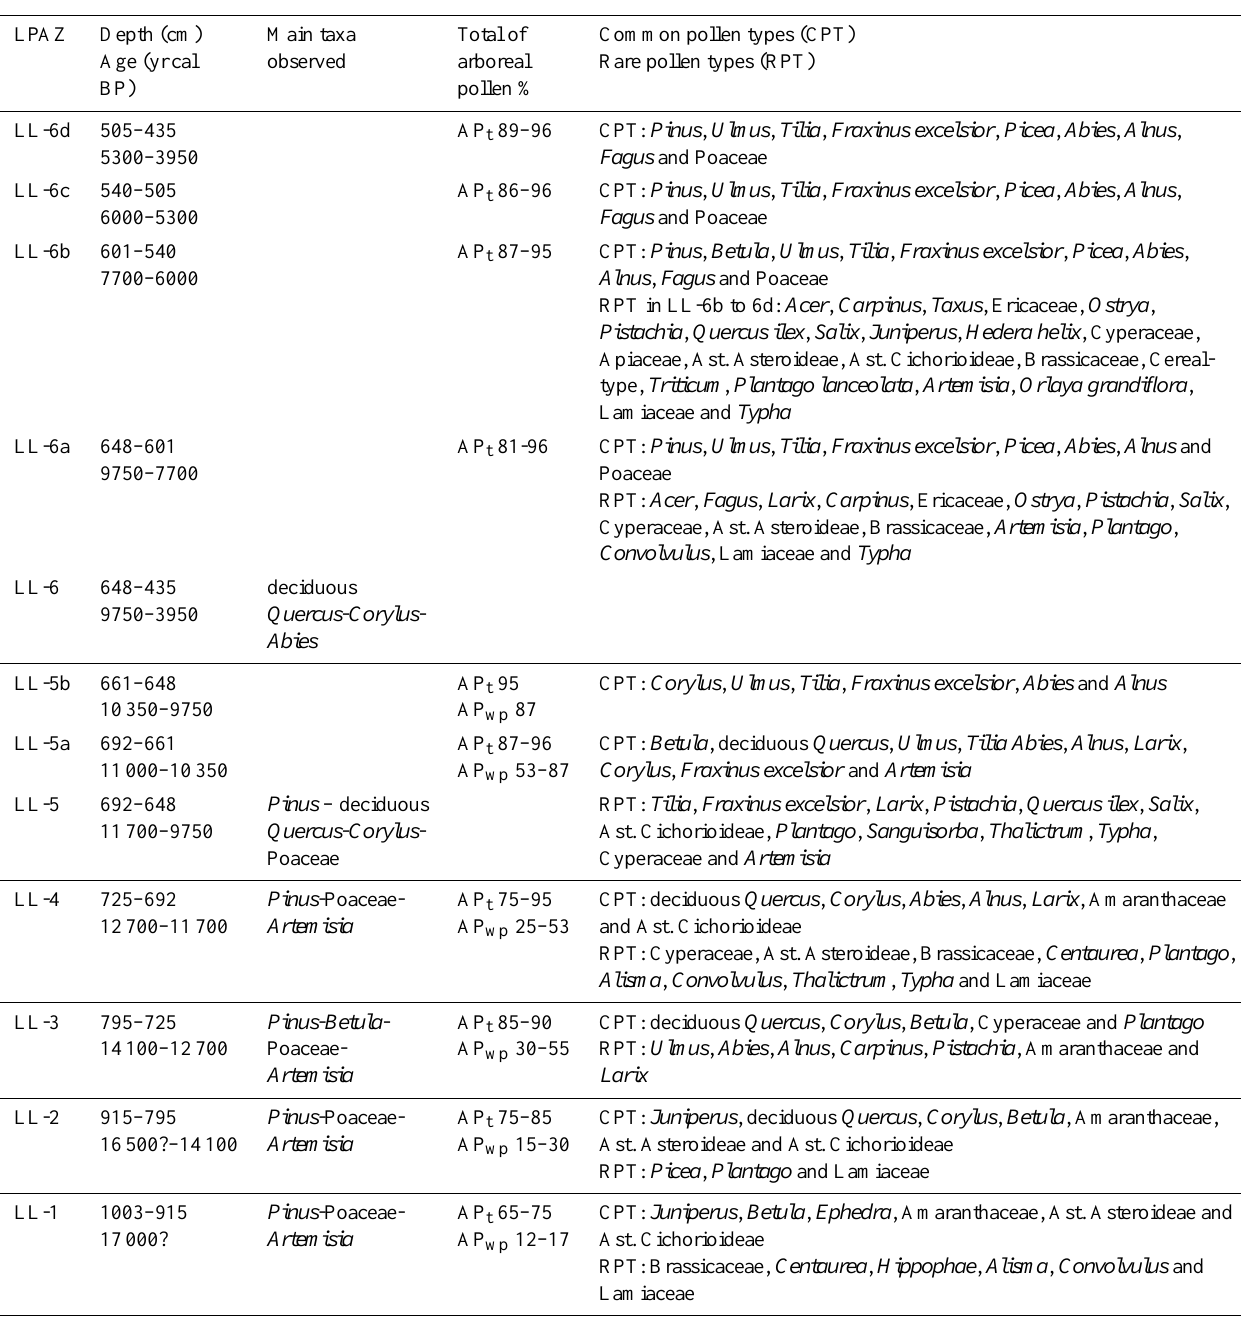
Table 2. Inventory of local pollen zones with depth and estimated ages, main taxa, total arboreal pollen (AP), and common and rare pollen types. Note that two ratios (AP t and AP wp ) are used – arboreal pollen without Pinus (AP wp ) was calculated by excluding Pinus (pine) pollen